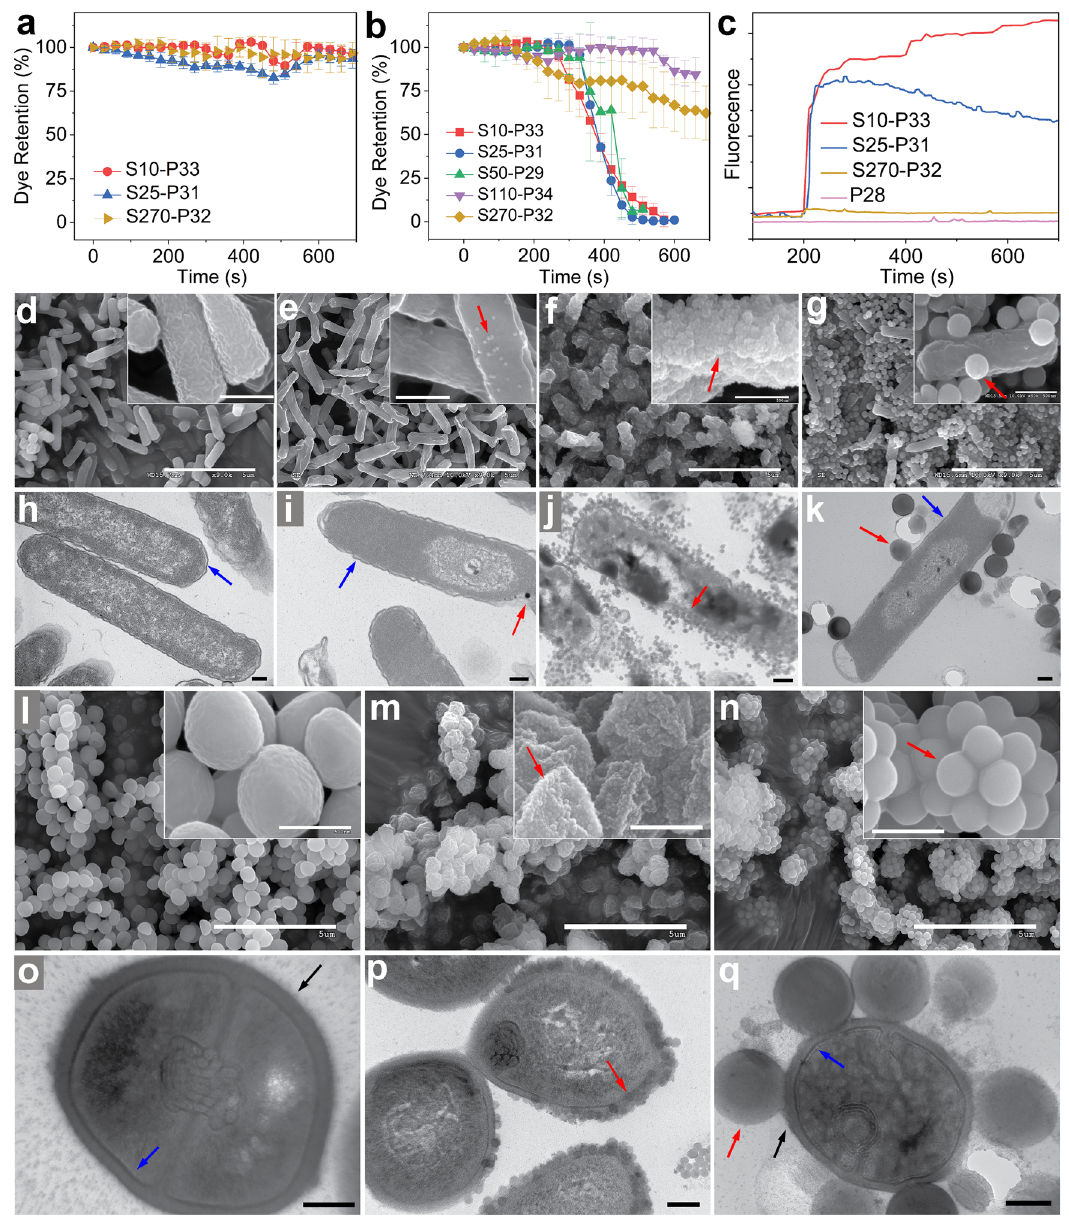
Fig. 3 Hydrophilic NPPBs are membrane-active antimicrobials that selectively disrupt bacterial instead of mammalian membranes with size- dependent activities. a , b Fluorescein release from GUVs that mimic mammalian cell and bacteria, respectively, incubated with model NPPBs (Error bars = Standard Deviation ( n = 3) in both a and b ). c Membrane permeation assays of E. coli incubated with model NPPBs and P28 control. d – k SEM ( d – g ) and cross-sectional TEM ( h – k ) of E. coli control ( d , h ), and E. coli incubated with S25 ( e , i ), S25 – P31 ( f , j ), and S270 – P32 ( g , k ), respectively. l – q SEM ( l – n ) and cross-sectional TEM ( o – q ) of S. aureus control ( l , o ), and S. aureus incubated with S25 – P31 ( m , p ), and S270 – P32 ( n , q ), respectively. The membrane, peptidoglycan layer, and nanoparticles are indicated by blue, black, and red arrows, respectively. Scale bars: 5 μ m (SEM), 500 nm (SEM inset), and 200 nm (TEM). Similar SEM and TEM micrographs as shown in d – q are consistent across all pictures of individual samples taken in different experiments ( n = mammalian cell-mimicking GUVs loaded with fl uorescein and NPPBs (Fig. 2c), suggesting that the hydrophilic nanoparticles used confocal microscopy to examine membrane integrity by don ’ t rupture mammalian membranes. The compatibility of monitoring the dye leakage from GUVs exposed to individual NPPBs to mammalian cells is further supported by the MTT NPPBs. Our previous study has shown that the P28 control assay (Fig. 2f): even though endocytosis may occur when HEK- doesn ’ t cause dye leakage from both types of GUVs 22 . Examples 293 cells encounter the hydrophilic nanoparticles, the viability of of time-lapse confocal microscopy images of GUVs interacting the cells still suggests that their membrane integrity is not with model NPPBs are shown in Supplementary Fig. 11. No dye leakage is observed from mammalian cell-mimicking GUVs incubated with NPPBs of any size (Fig. 3a). This is consistent with the NPPBs, rapid and complete dye leakage indicative of hemolysis assays that revealed very weak hemolytic activity for all